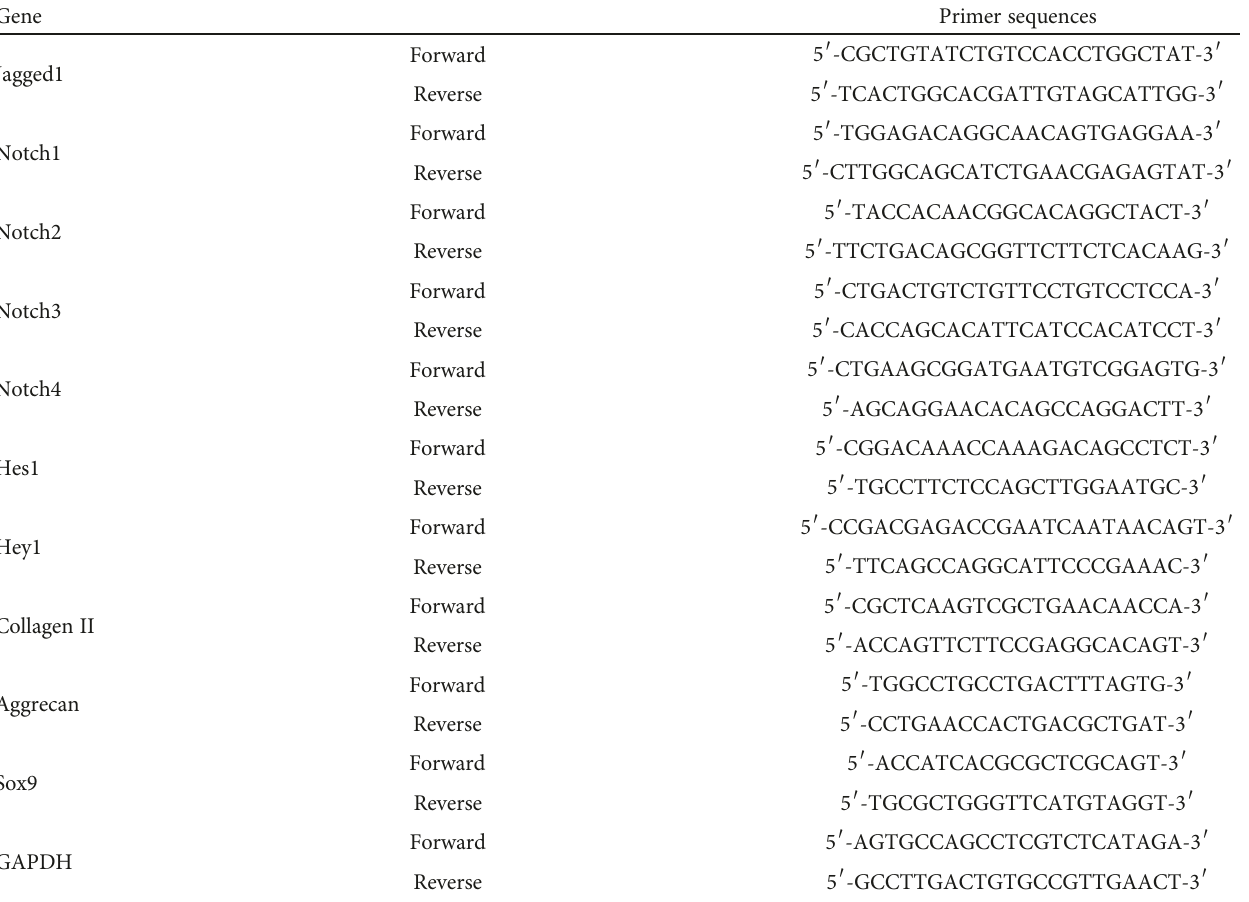
Table 1: The primer sequence of